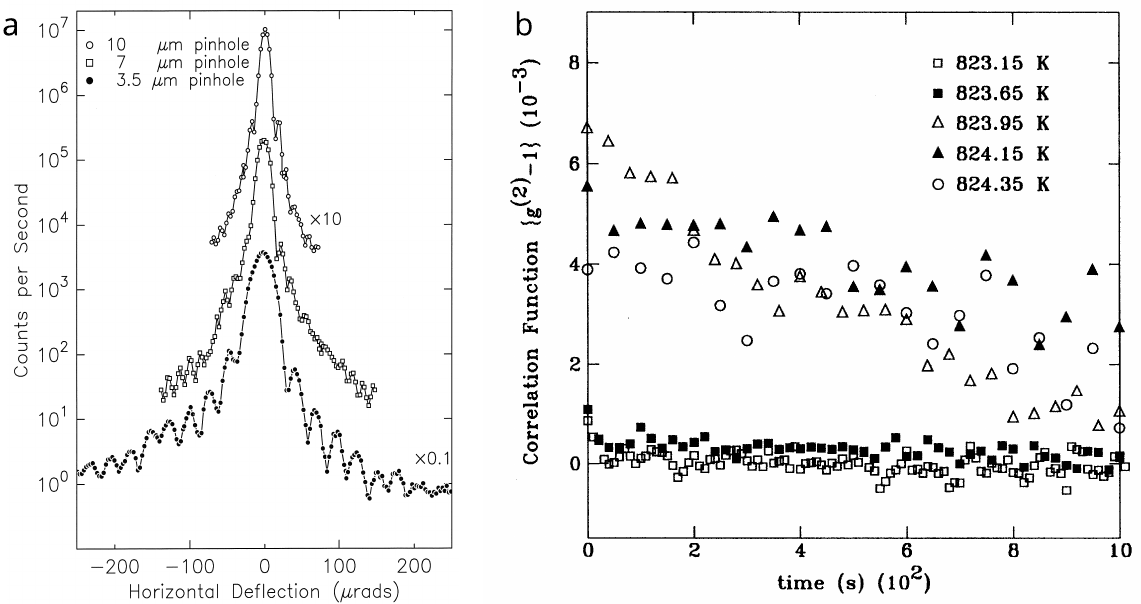
Figure 1. ( a ) Airy fringes from Fraunhofer diffraction from slits of different sizes as indicated. Data has been measured in the commissioning of the ID10 beamtime at ESRF, the first dedicated beamline for coherence applications [1]. Figure reproduced from [2]. Copyright 1997 Society of Photo-Optical Instrumentation Engineers (SPIE). ( b ) g 2 functions from 1 1 ) superlattice reflection measured at ID10 [21] showing fluctuations above the order-disorder transition Fe 3 Al at the ( 1 2 2 2 temperature of T c = 823.8